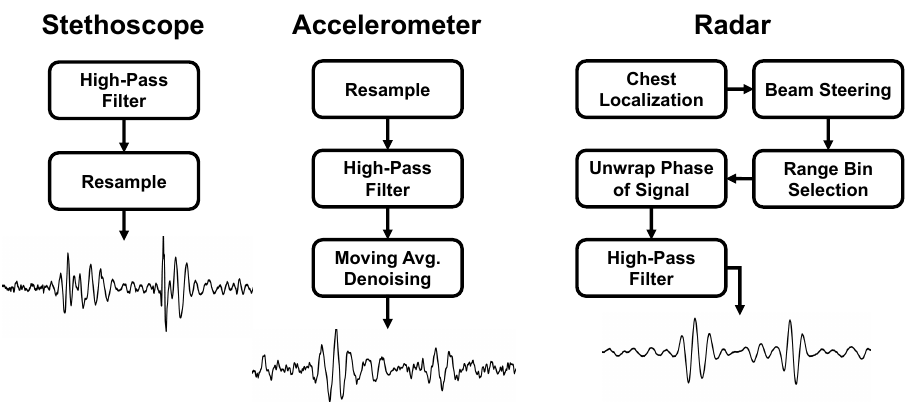
Figure 6. Comparison of the signal processing steps and final heart sound waveform for each of the measurement